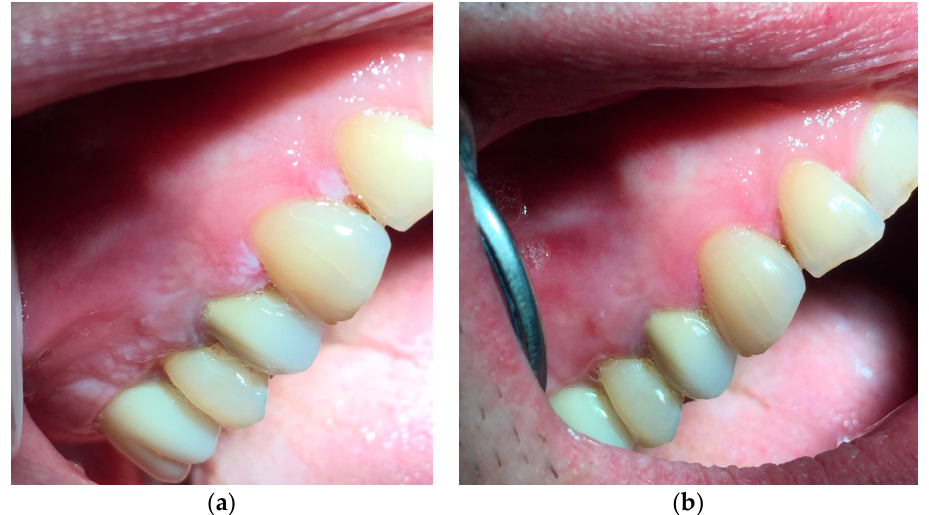
Figure 7. ( a ) Whitish and irregular area in the gingival mucosa. ( b ) Three weeks after the beginning of the treatment.